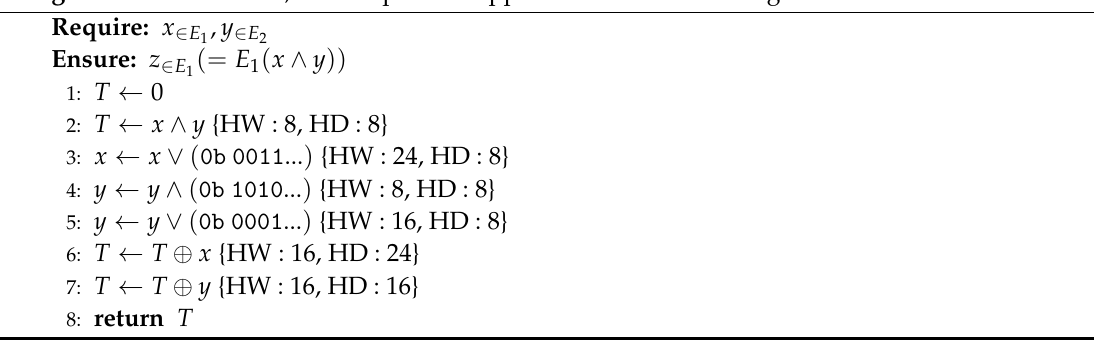
Algorithm 2: ConstAND , AND Operator Applied to Power-balancing